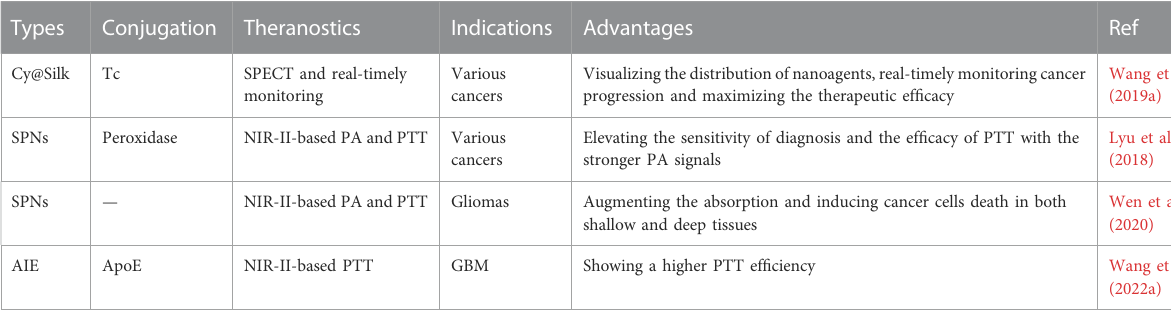
TABLE 3 The role of novel polymeric nanoagents in cancer